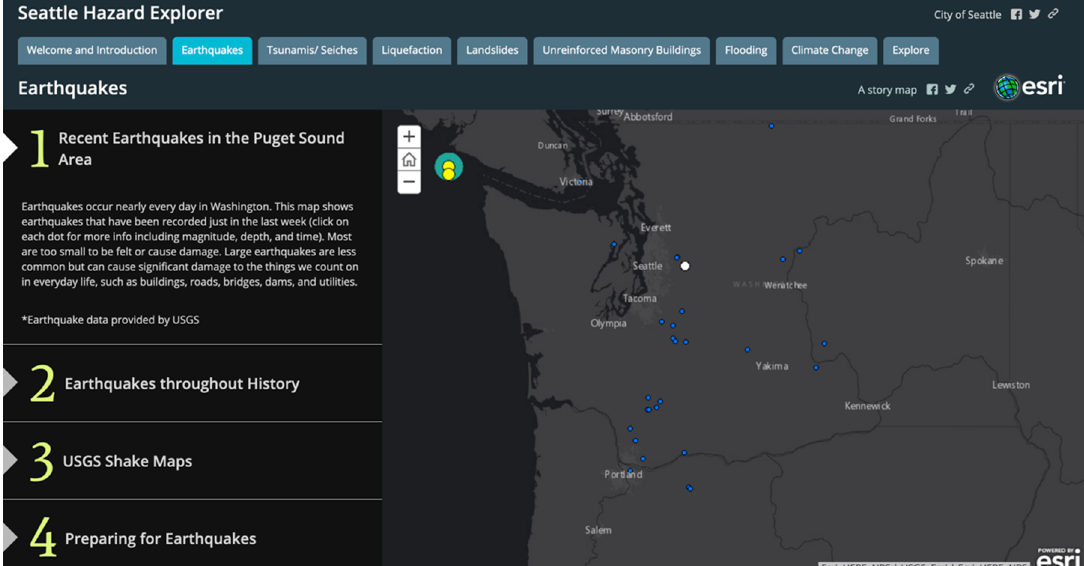
Figure 7. Seattle hazard explorer story map (https://tinyurl.com/j9ewsnm), where the City of Seattle informs citizens about the natural hazards than can affect the area.